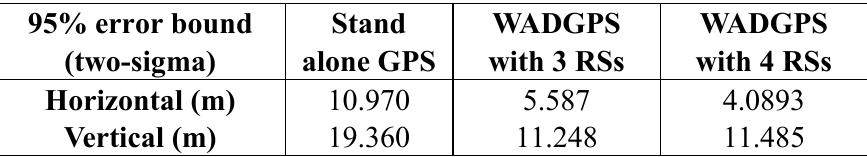
Table 6. Accuracy of positioning performance (Taipei